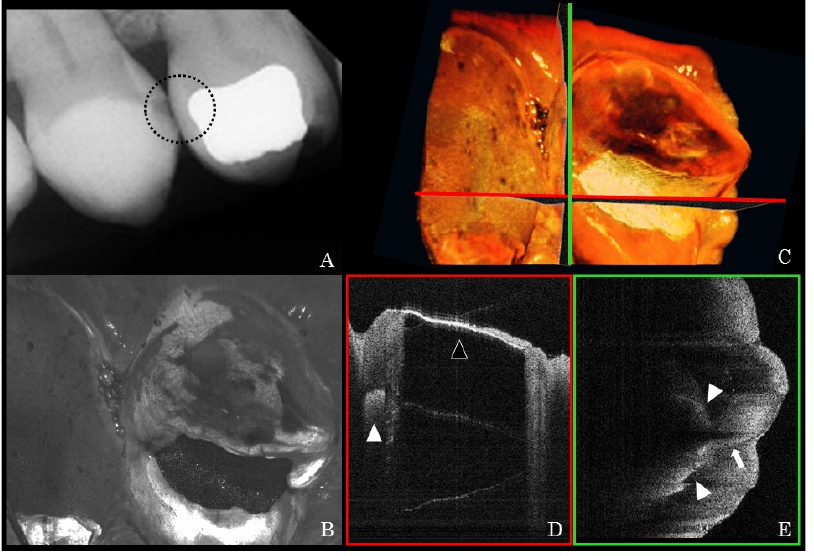
Figure 3. Representative bite-wing X-ray image of upper right premolars ( A ) and the corresponding OCT XY en-face image at the similar area ( B ). Mesial-distal and buccal-lingual cross-sectional images ( D , E ) at horizontal and vertical lines on the 3D image ( C ) were reconstructed from the OCT raw data. In the mesial-distal cross-section ( D ), the bright line at the occlusal surface (blank arrow head) indicates that OCT laser completely reflected at the amalgam restoration and could not obtain the inner image. The high signal intensity at the distal part of the first premolar indicates proximal caries ( D, E bold arrow heads). In the buccal-lingual cross-section at the distal proximal part ( E ), the high signal line indicates vertical crack progress (bold arrow). Crack formation results in light scattering are observed as a high brightness boundary within seemingly sound dental tissue. These cracks are frequently observed at the marginal ridges of teeth with old occlusal amalgam restorations.